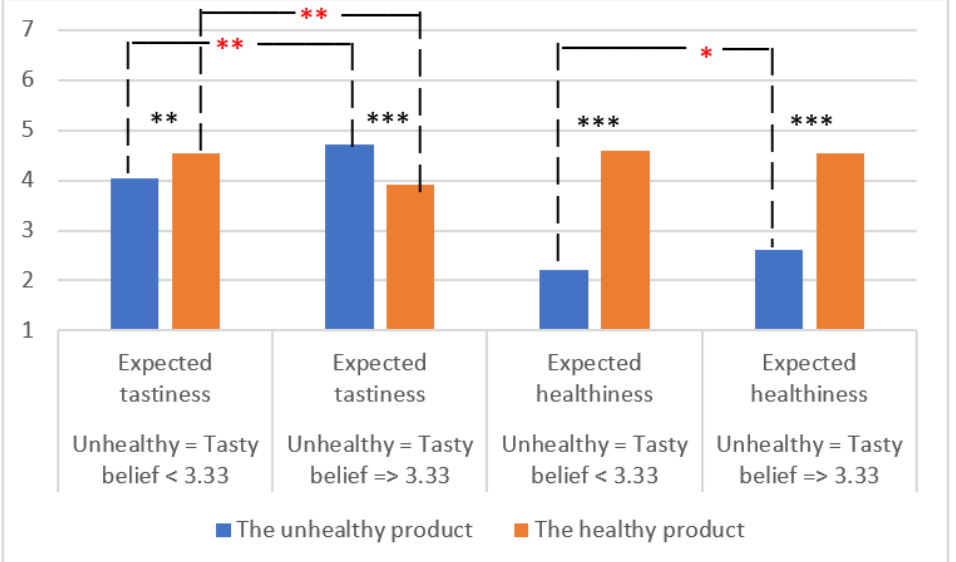
Figure 6. The effect of unhealthy = tasty belief on the expected tastiness and healthiness of the unhealthy (fried potatoes and sausages) and the healthy product (vegetable lentil soup). The differences between expected tastiness and healthiness of different products are marked with *** ( p < 0.001), ** ( p < 0.010 (paired-samples t -test). The differences between participants with either higher unhealthy = tasty belief ( ≥ 3.33) or lower unhealthy = tasty belief (<3.33) are marked with ** ( p < 0.010), * ( p < 0.050) (independent-samples t -test).